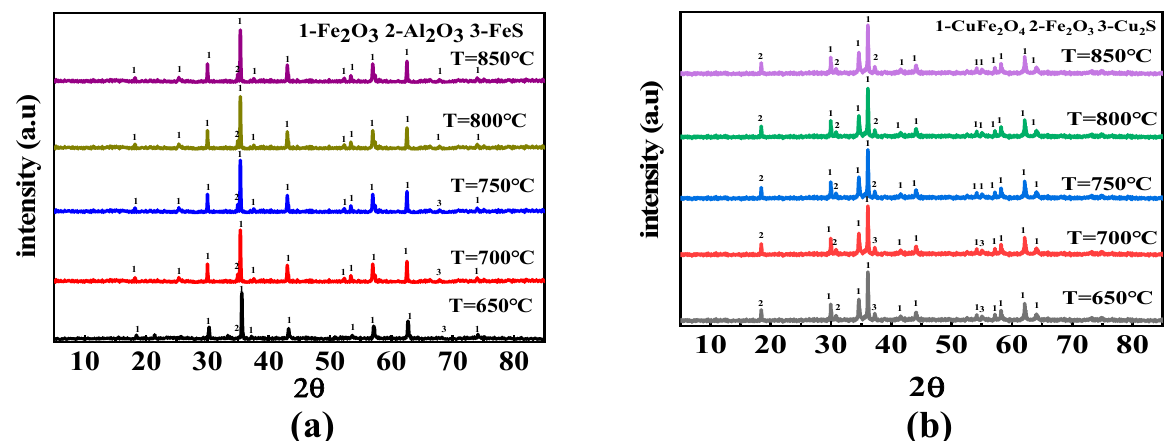
Figure 10. XRD patterns of ( a ) Fe 2 O 3 /Al 2 O 3 and ( b ) CuFe 2 O 4 at different reaction temperatures.